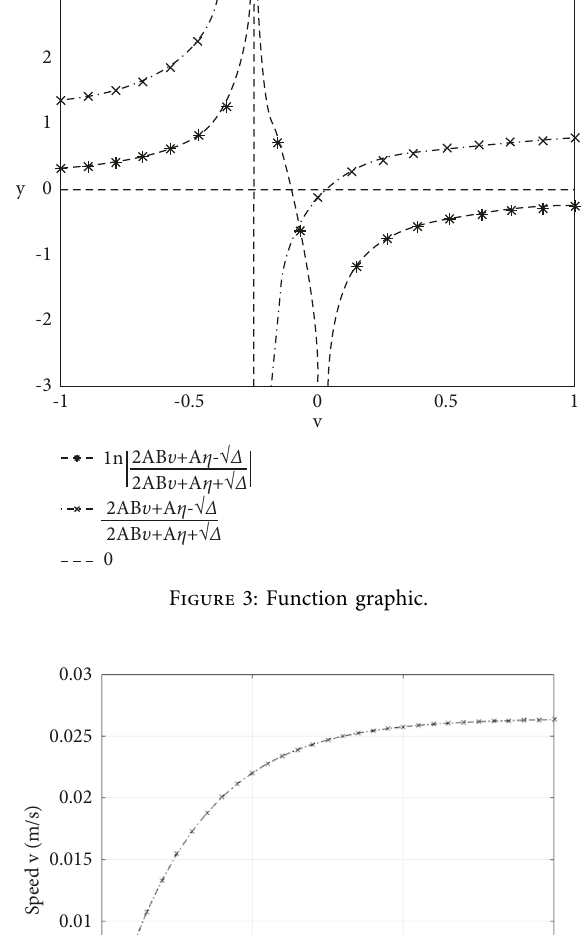
Figure 4: Velocity-time relationship of the